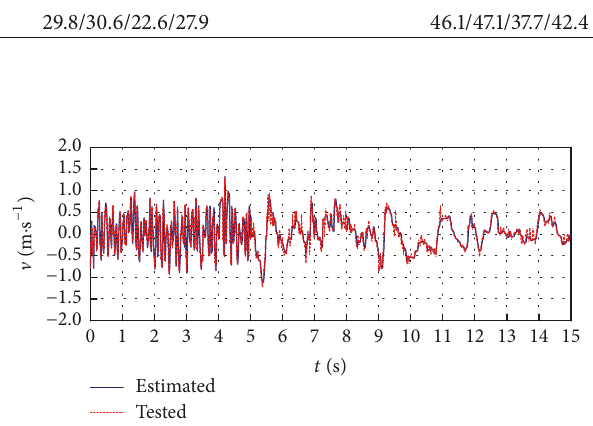
Figure 8: The typical disturbance input and its